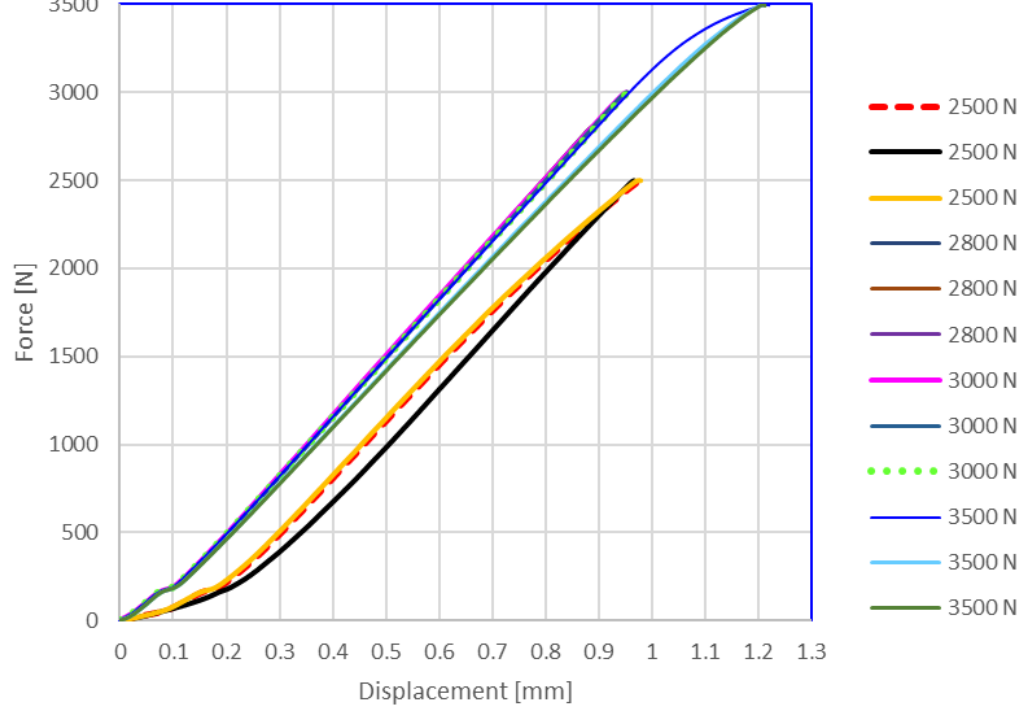
Figure 11. Proof of compression elastic range up to 3000 N for horizontally layered samples.